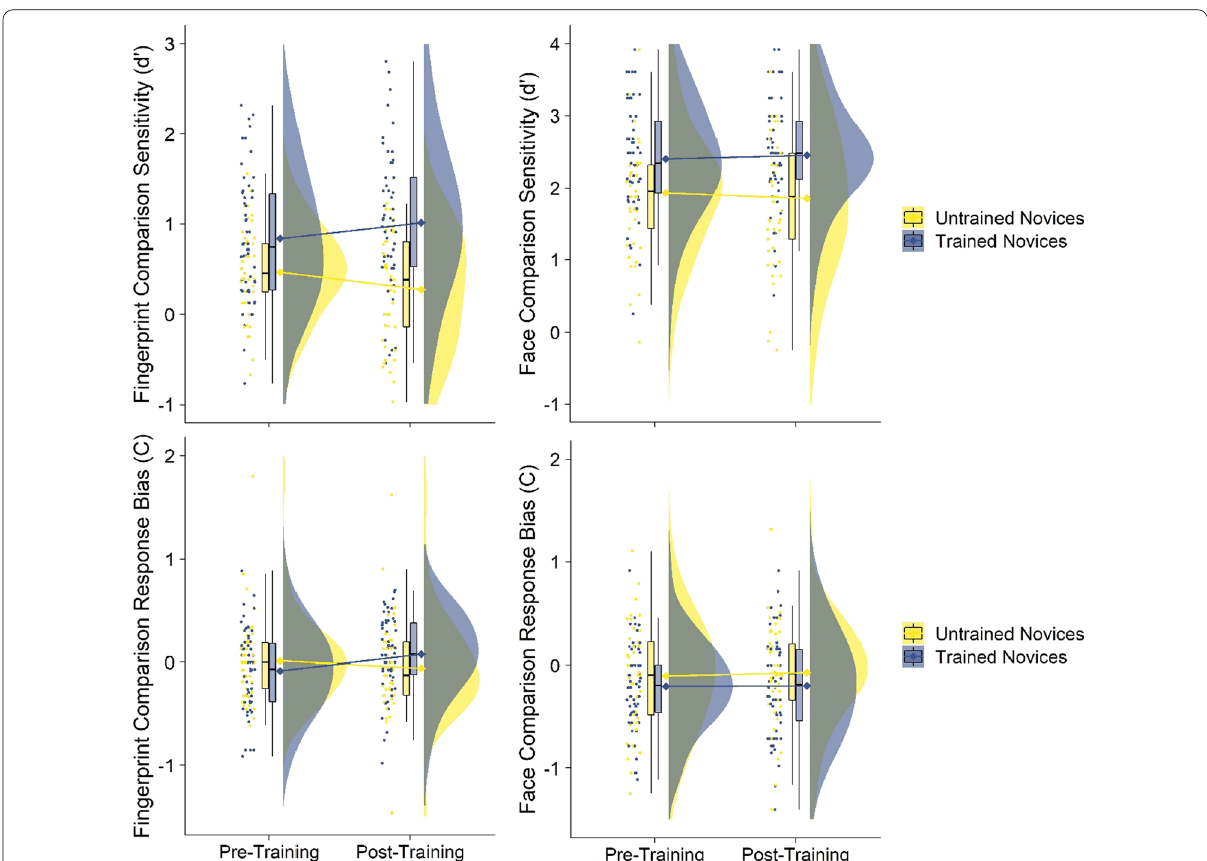
Fig. 5 Sensitivity (upper panel) and response bias (lower panel) in the fingerprint (left panel) and face (right panel) comparison tasks by time and condition in Experiment 1. Raincloud plots depict (left-to-right) the jittered participants’ averaged data points, box-and-whisker plots, means (represented by diamonds) with error bars representing 1 SE, and frequency ±